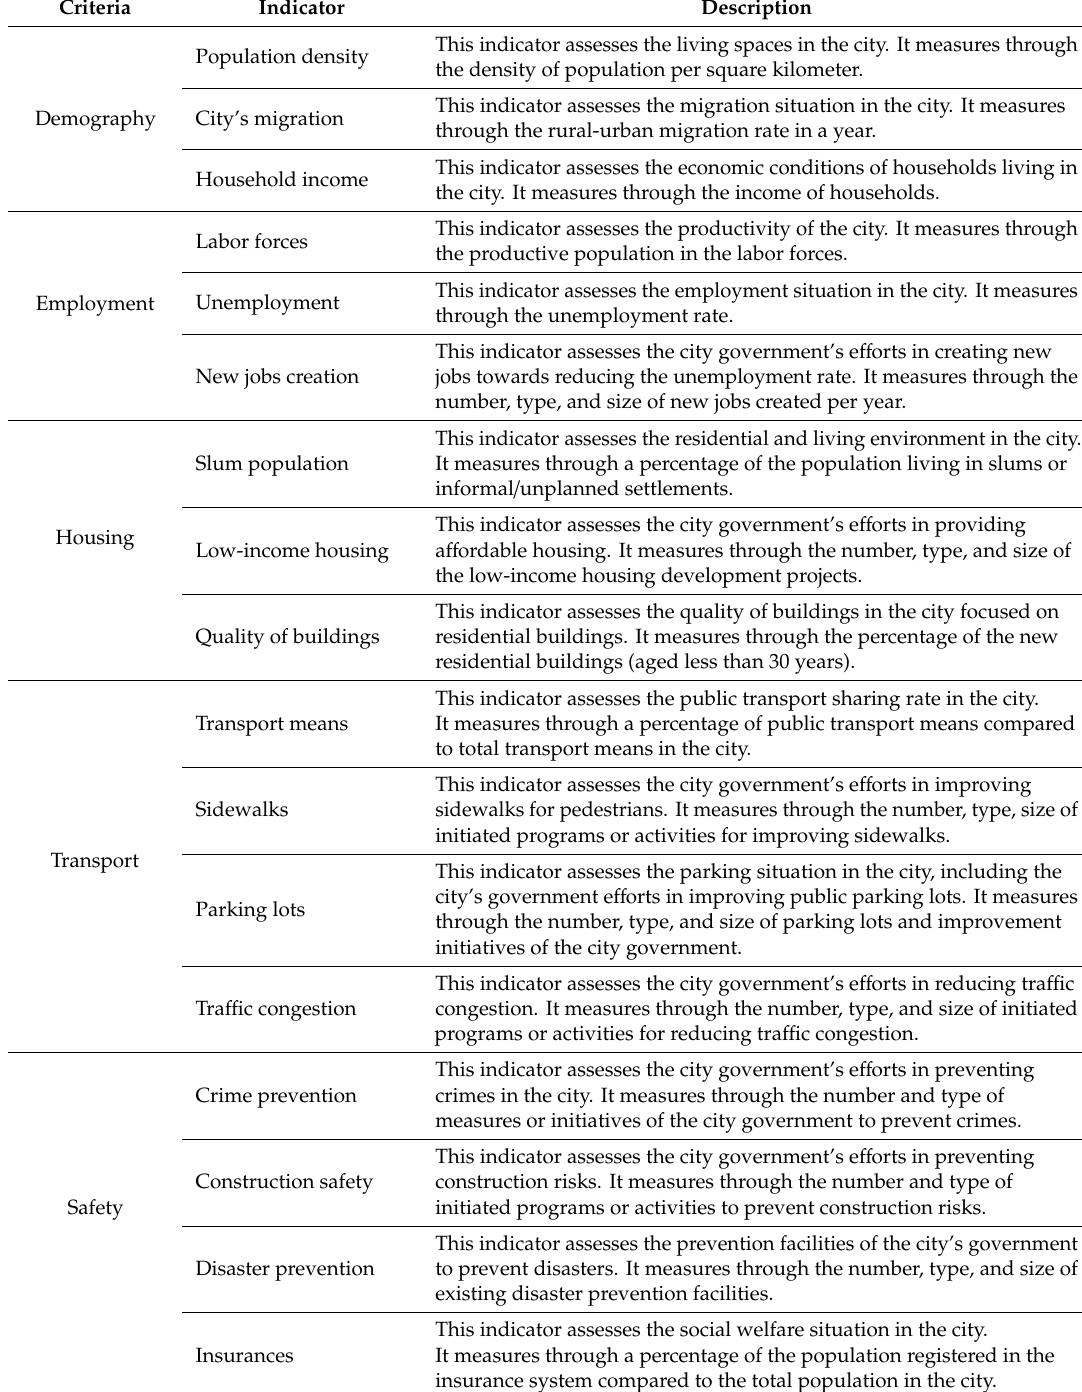
Table 1. The nine criteria and their assessment